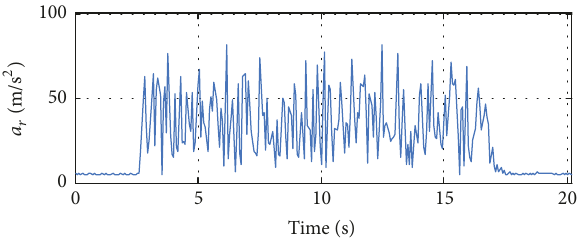
Figure 3: The magnitude of acceleration detected by an accelerom- eter. Because the sensors are set to sense any vibration in three axes up to acceleration of ±6𝑔 , the maximum of the amplitude of acceleration vector can reach as high as